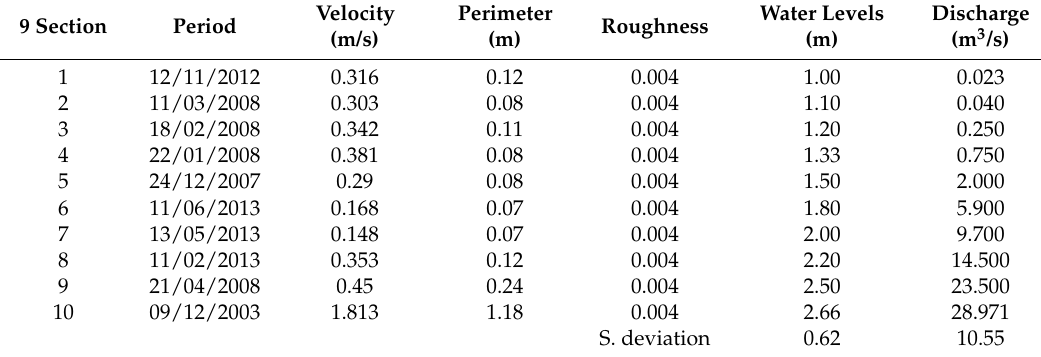
The hydrodynamic parameters calculated in 10 surveyed cross-sections at the KALAYA